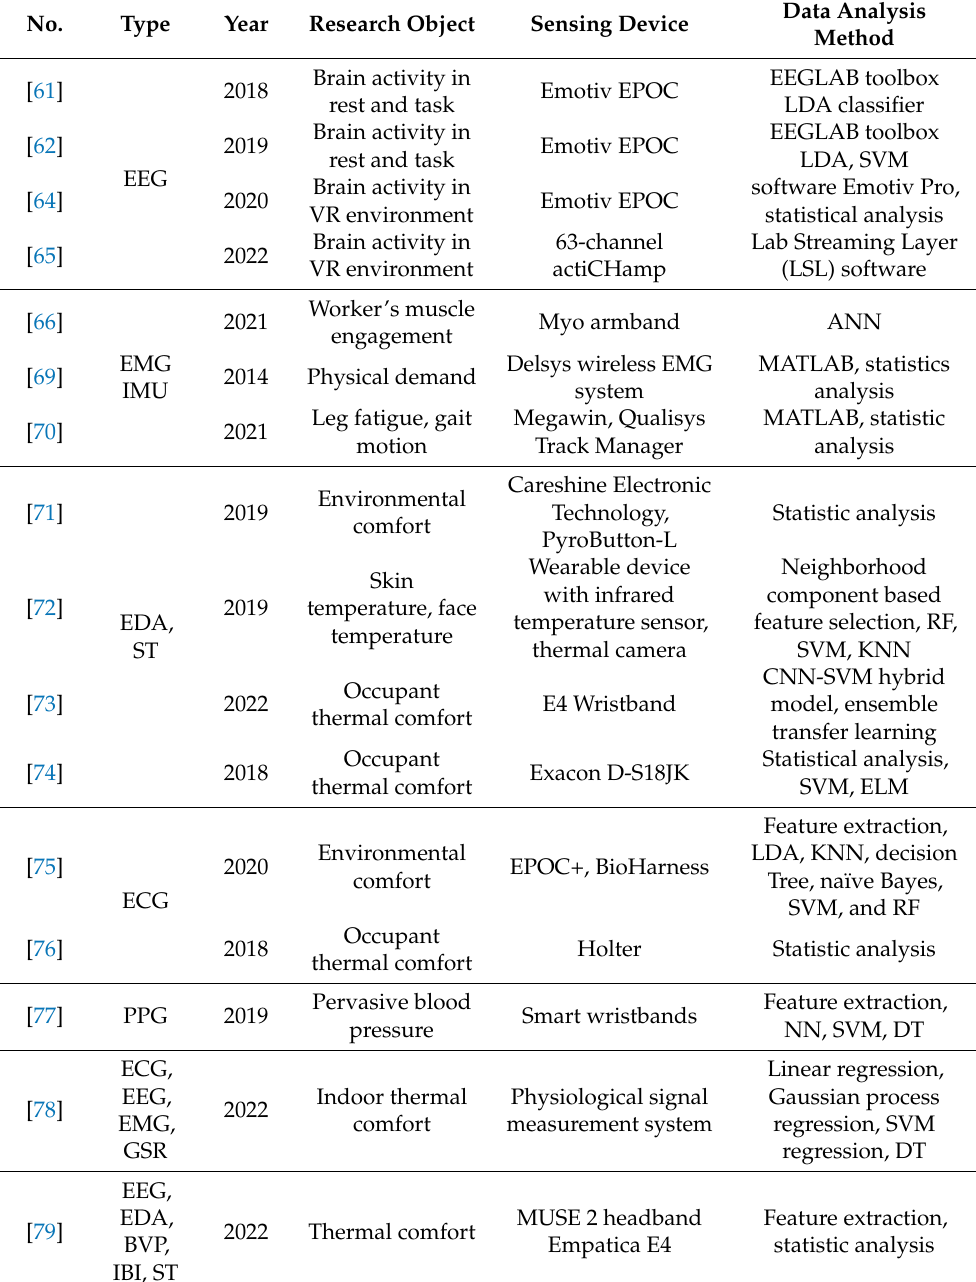
Table 5. The list of references for occupant physiological indicators sensing.